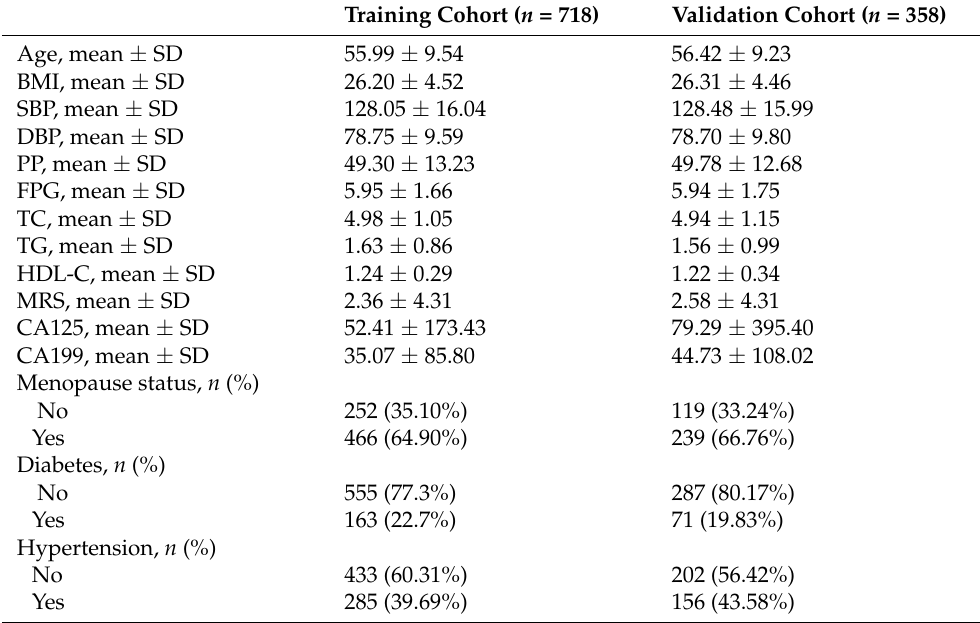
Table 2. The demographics and pathological characteristics of patients in the training ( n = 718) and the validation ( n = 358)